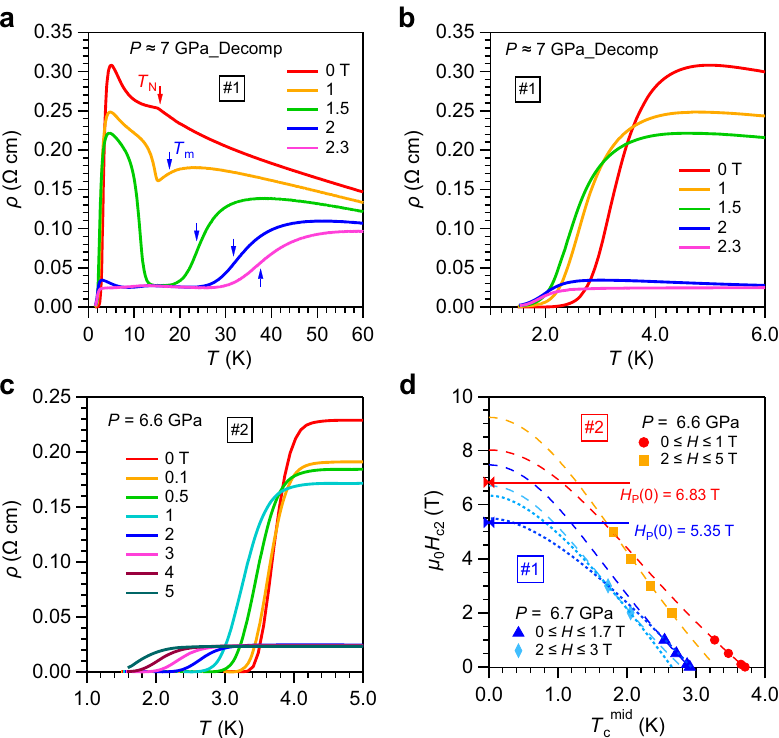
Fig. 3 Magneto-transport properties of EuTe 2 . ρ ( T ) of sample #1 at ~7 GPa (Decompression) under various fi elds in the temperature range of a 0 – 60 K and b 1 – 6 K. c Low-temperature ρ ( T ) of sample #2 at 6.6 GPa under various fi elds. d Temperature dependence of the upper critical fi eld μ 0 H c2 for sample #1 at 6.7 GPa and sample #2 at 6.6 GPa, respectively. The broken and dotted lines in d represent the fi tting curves by using the Ginzburg – Landau (G – L) and Werthamer – Helfand – Hohenberg (WHH) models, respectively. The Pauli-limiting fi elds H p (0) are given and indicated by the horizontal lines in d .